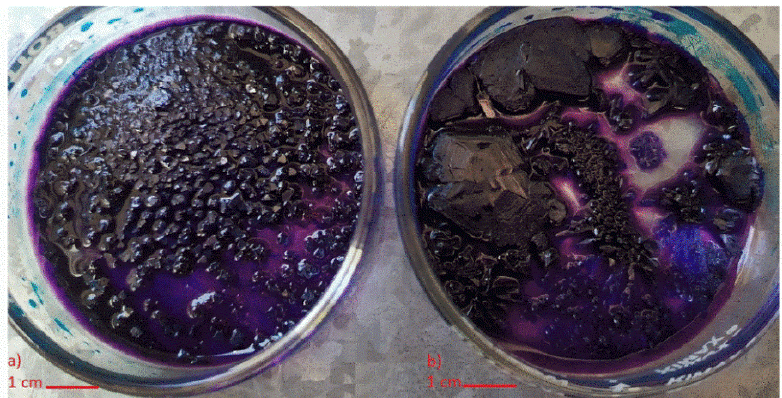
Figure 4. ( a ) crystals without UV assistance; ( b ) crystals with UV assistance.